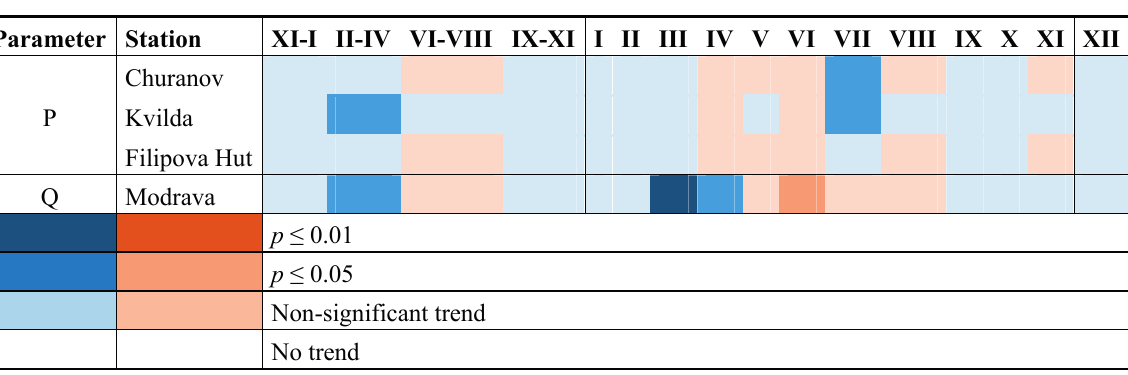
Table 3. Mann-Kendall test of seasonal and monthly precipitation (P) and discharge (Q) trends during 1961–2010.